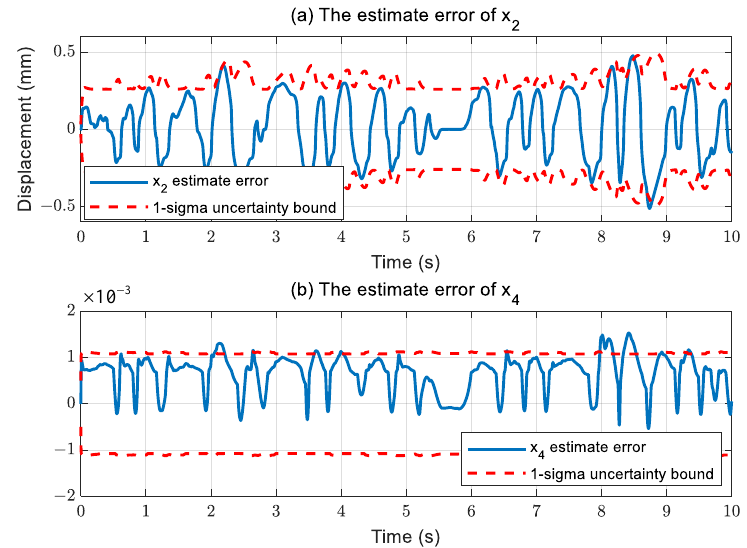
Figure 15. State observation error and uncertain